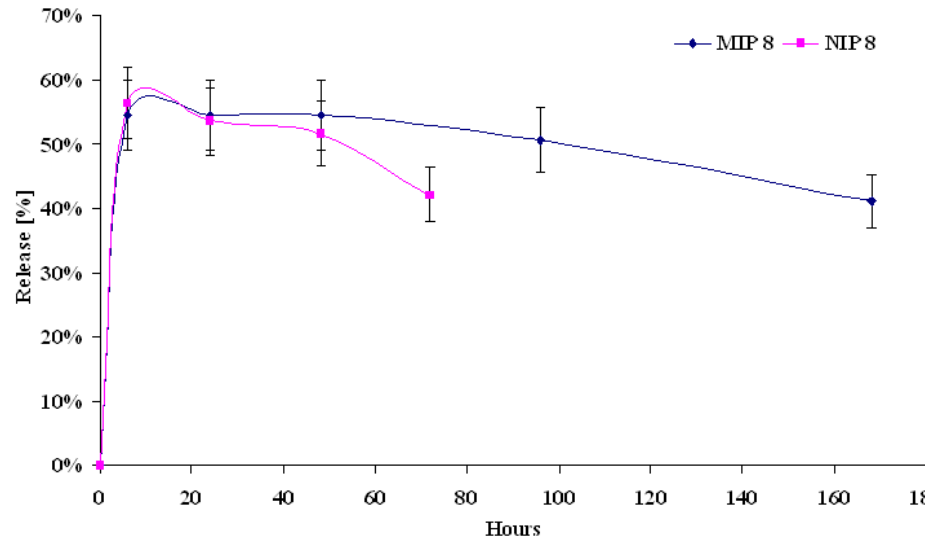
Figure 9 . Release profiles of molsidomine from MIP8 and NIP8 at exchange of half of volume of releasing